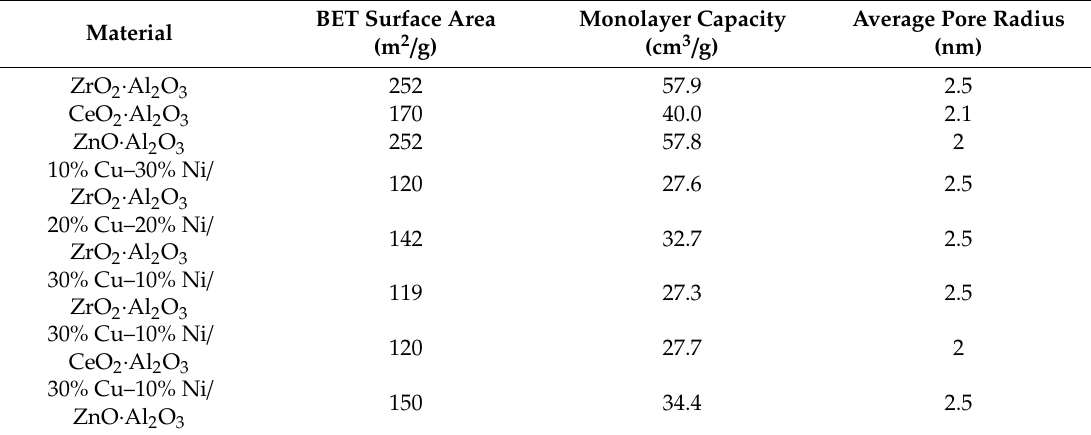
Table 2. The specific surface area of calcined supports and bimetallic Cu-Ni catalysts.